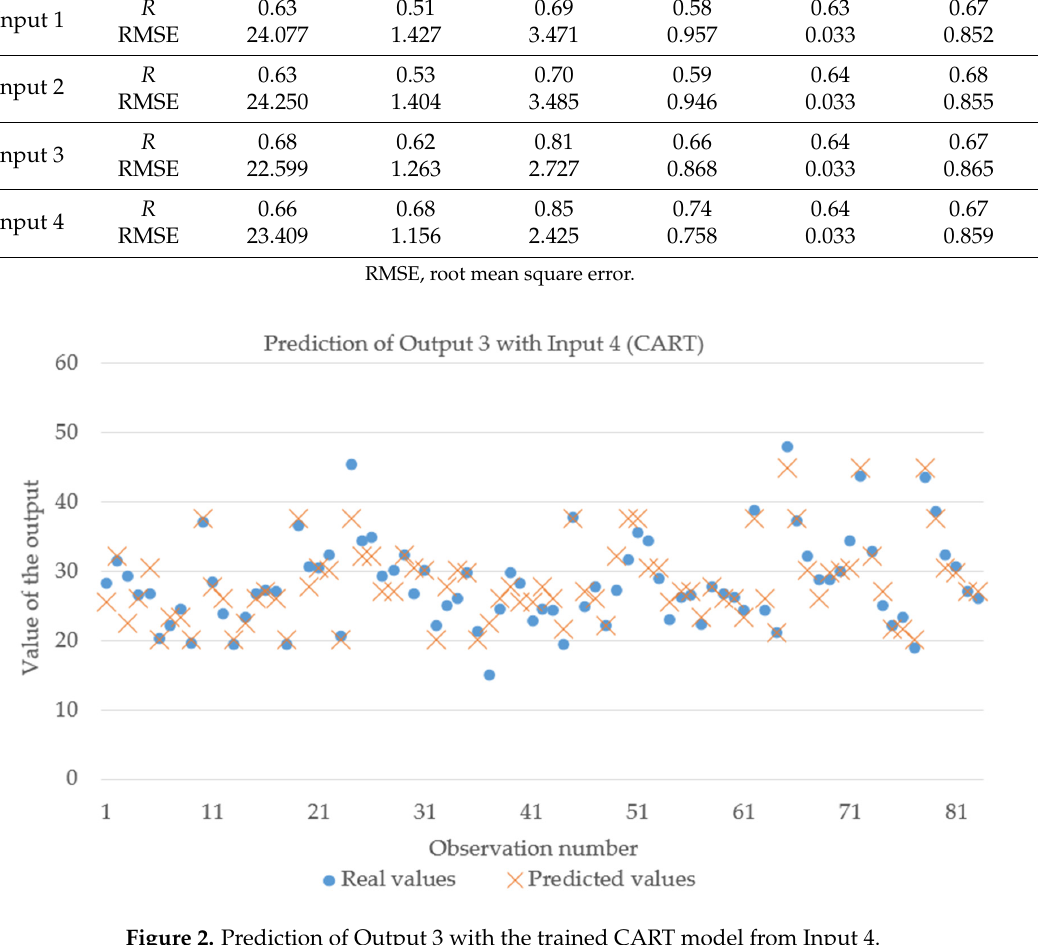
Figure 3. Prediction of Output 4 with the trained CART model from Input 4. 4. Discussion PCA analysis provides valuable information regarding the role played by each variable in the predictive model (Table 3). The four input sets were studied and their principal components show the following: regarding Input 1, there is a linear dependence between two of the variables (quite obvious, since % Sapwood and % Heartwood make 100%). The remaining Input sets do not show a linear dependence between their variables and none of them could be removed without losing a considerable amount of information. According to the results obtained, multiple linear regression turned out not to be appropriate for the given data when the input was Input 2, Input 3 or Input 4 since the resulting R 2 statistic was negative. When Input 1 was used, multiple linear regression performed poorly whatever the output